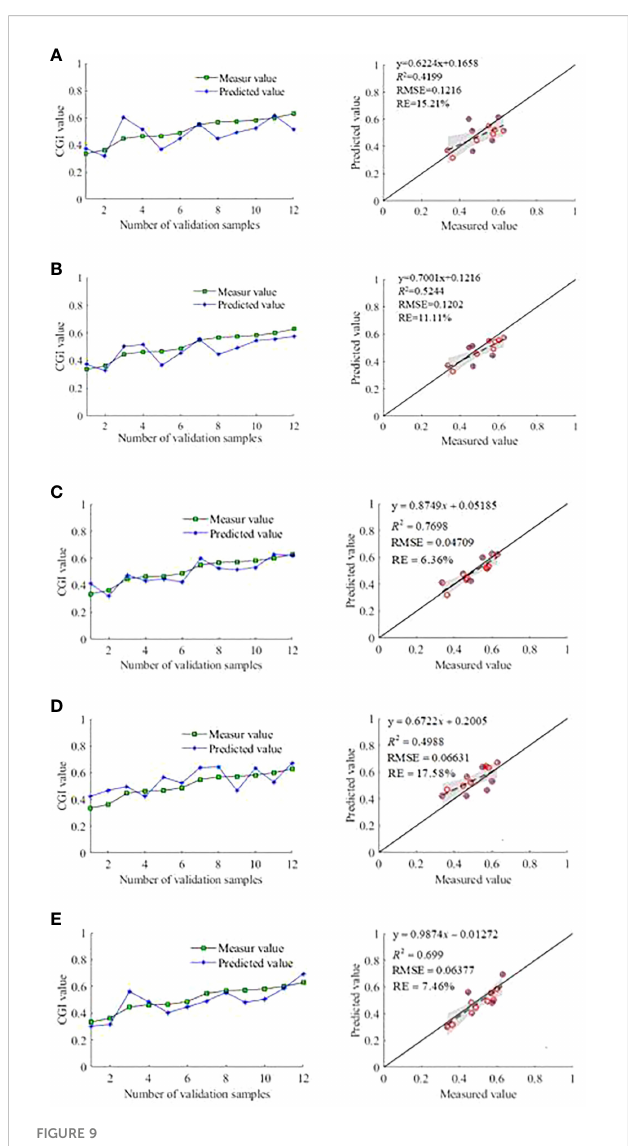
FIGURE 9 Accuracy validation of each modeling method. (A) Inverse CGI accuracy veri fi cation of models built using the original spectra (B) . Inverse CGI accuracy veri fi cation of models built using the optimal spectra screened by the correlation analysis (C) . Inverse CGI accuracy veri fi cation of models built using the optimal spectra screened by the SPA method (D) Inverse CGI accuracy veri fi cation of models built using the optimal spectra screened by the OIF method (E) . Inverse CGI accuracy veri fi cation of models built using the optimal spectra screened by the BCI